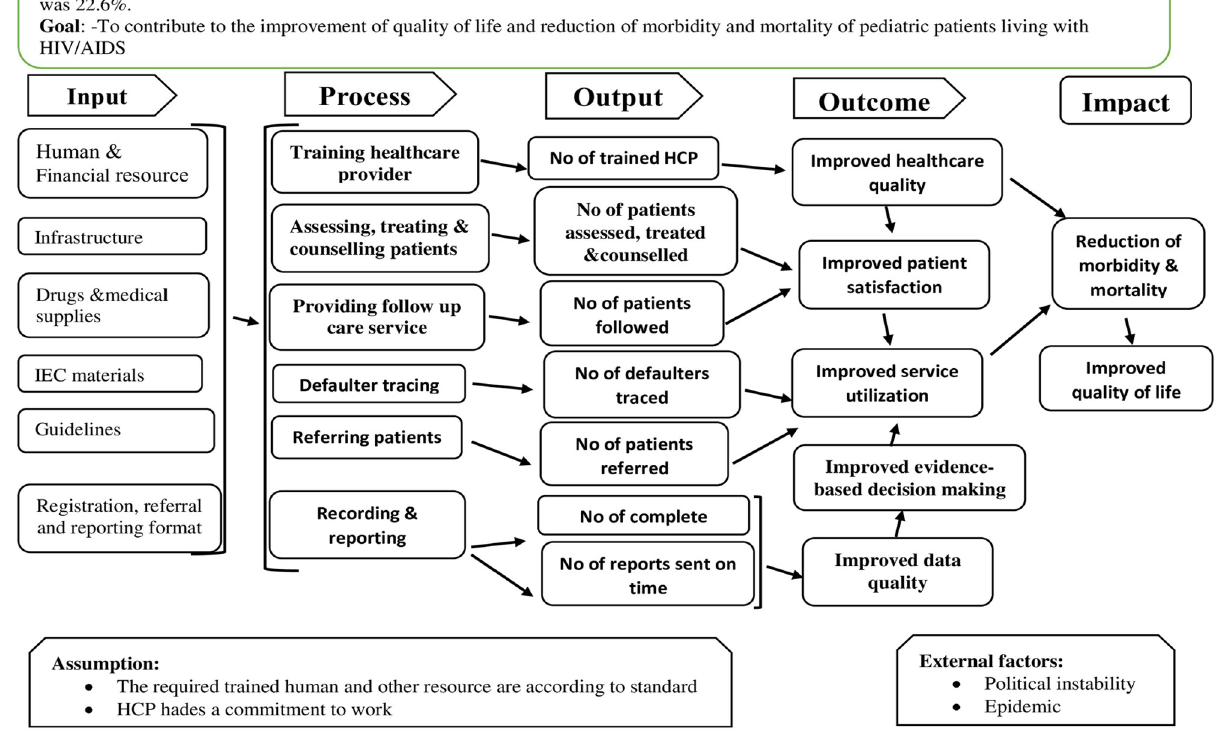
Fig 1. The logic model of the pediatric ART